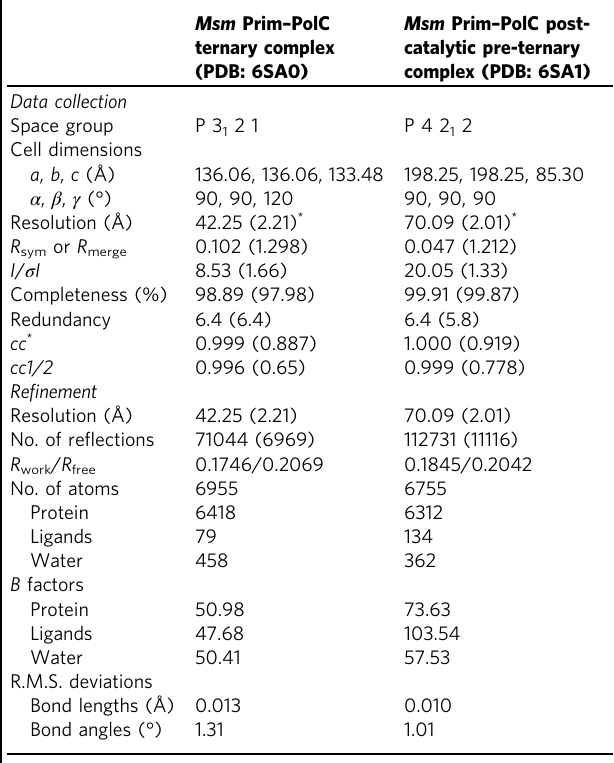
Table 1 Data collection and re fi nement statistics (molecular